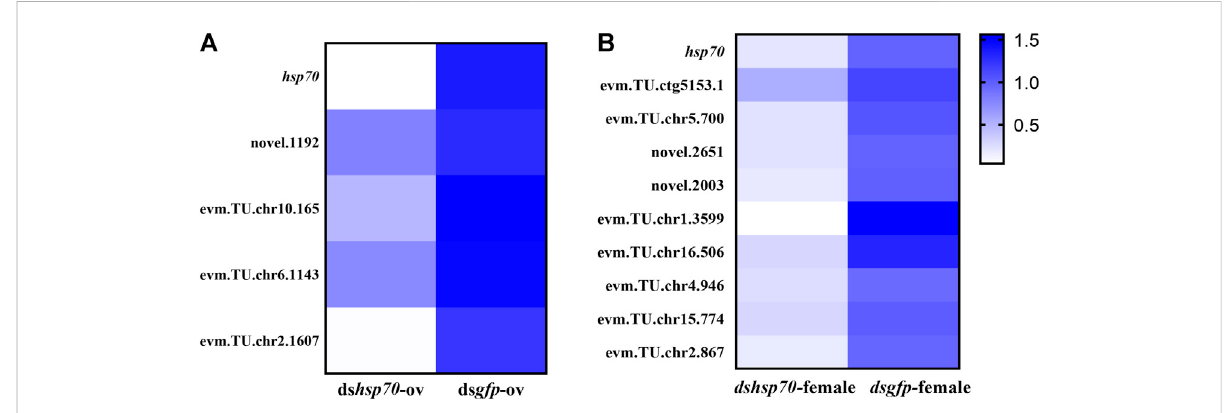
FIGURE 4 Veri fi cation of differential gene expression between two RNA interference-treated groups by quantitative real-time polymerase chain reaction represented as heat maps. (A) ds hsp70 -ov vs. ds gfp -ov. (B) ds hsp70 -female vs. ds gfp